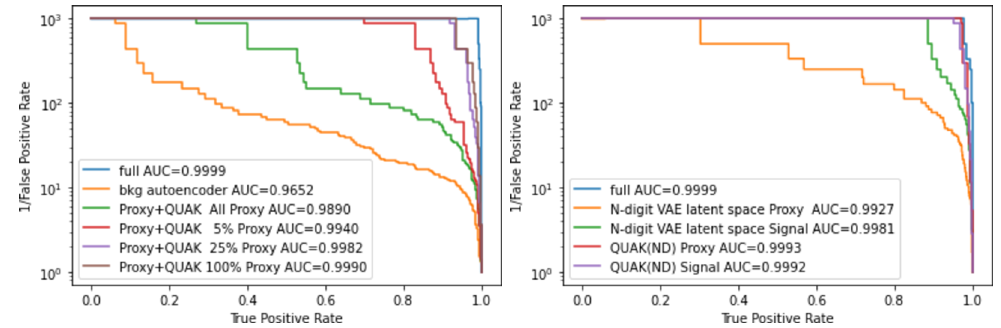
Figure 4 . Performance in separating the digit 5 from 9 for a fully supervised network (full) with (Left) a linear discriminant on the space of digits 0-8 using a proxy signal that is X% digit 7 and 100-X% digit 0. (Right) Performance comparison of QUAK compared to an 9-dimensional latent space from a VAE trained on all digits 0–8 to separate out the digit 5 with the digit 9 with QUAK. To perform discrimination on the latent space a supervised network is trained on the latent space produced from the digit 5 against a latent space produced from the digits Signal(9)/Proxy(7). Performances are compared to QUAK space using a linear discriminant on the 0–8 digit loss space again using either